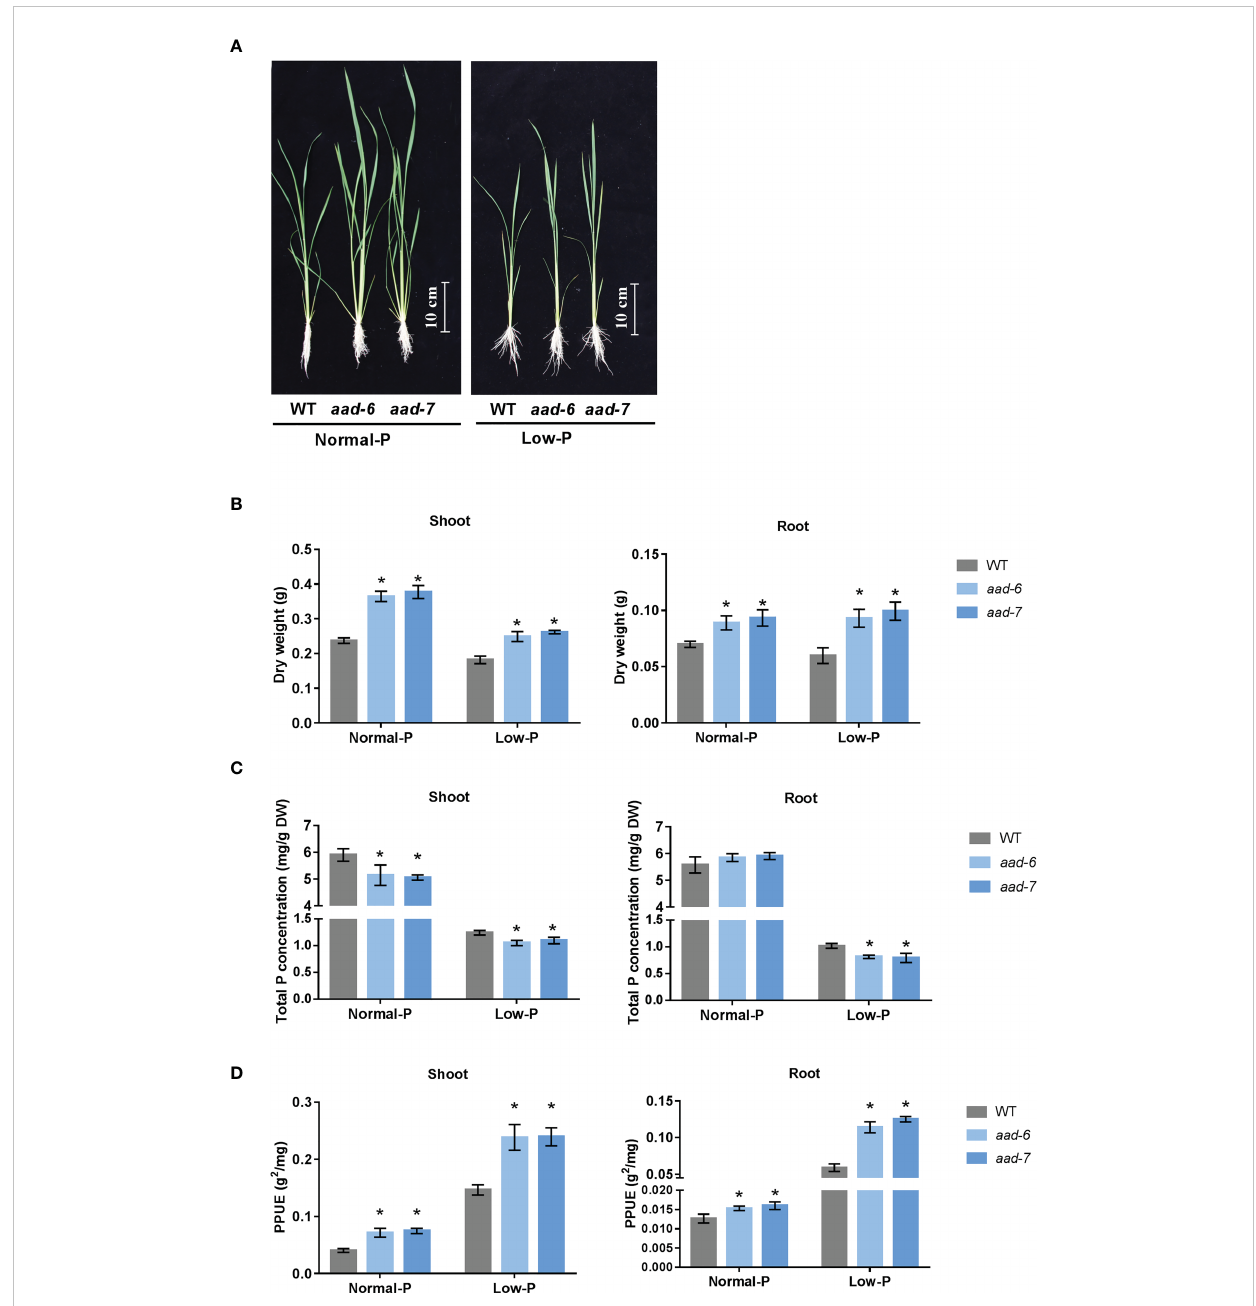
FIGURE 3 Phenotypic characteristics and total P concentration analysis of wild-types and aad mutants. (A) Growth performance of wild-type and aad mutants grown in a solution culture with normal Pi (200 m M) or low Pi (10 m M) supply for 30d. (B) Shoot and root dry weight of wild-type and aad mutants. (C) Total P concentration in shoot and root. (D) Physiological phosphorous use ef fi ciency. Values represent means ± SD of three biological replicates *P <